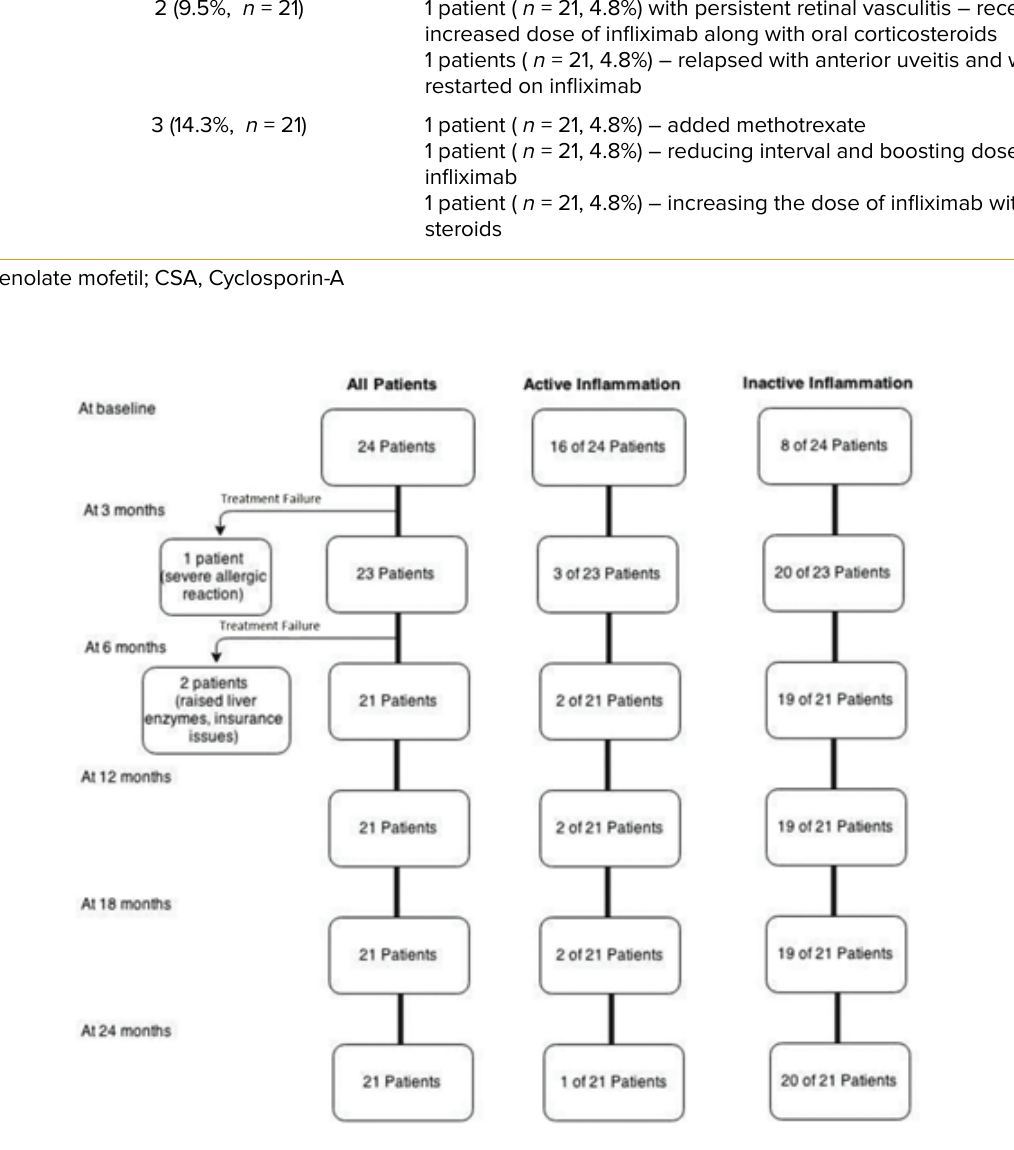
Figure 1. The number of patients in total, with active and inactive disease at each follow-up visits.